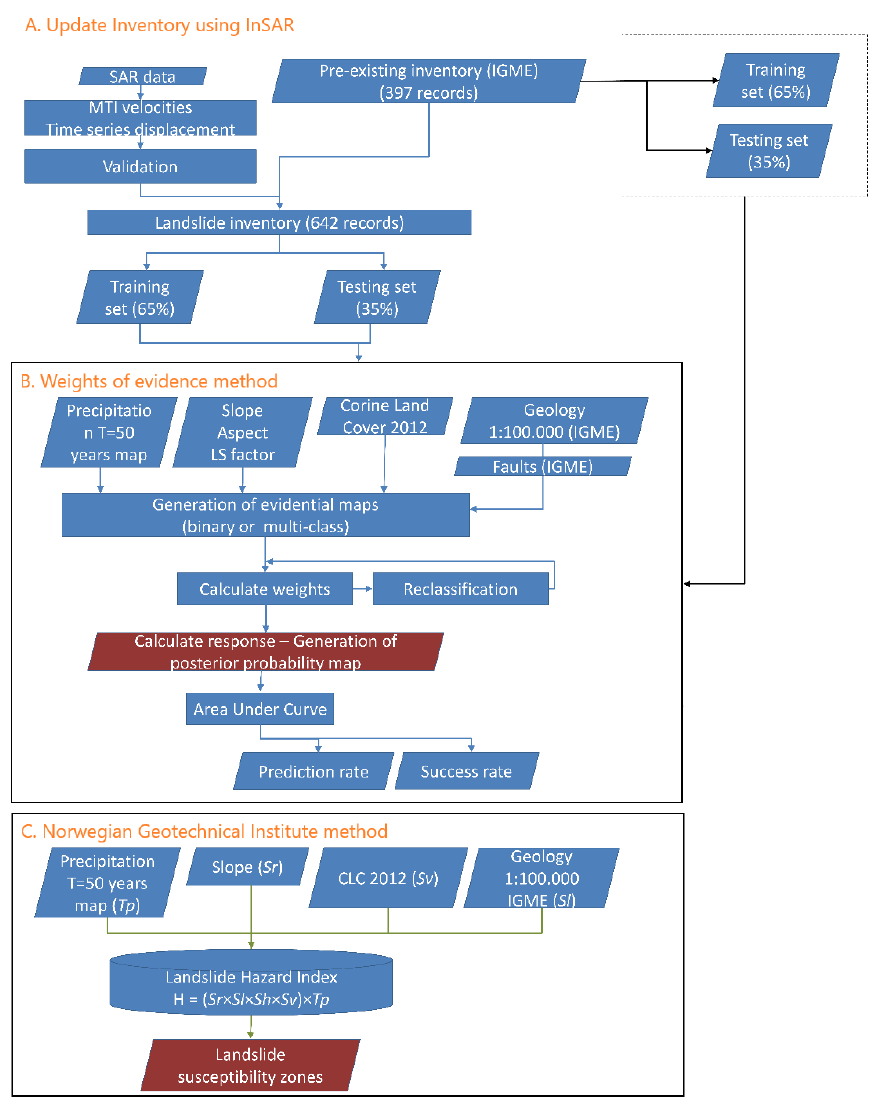
Figure 5. Workflow towards landslide inventory and susceptibility assessment.